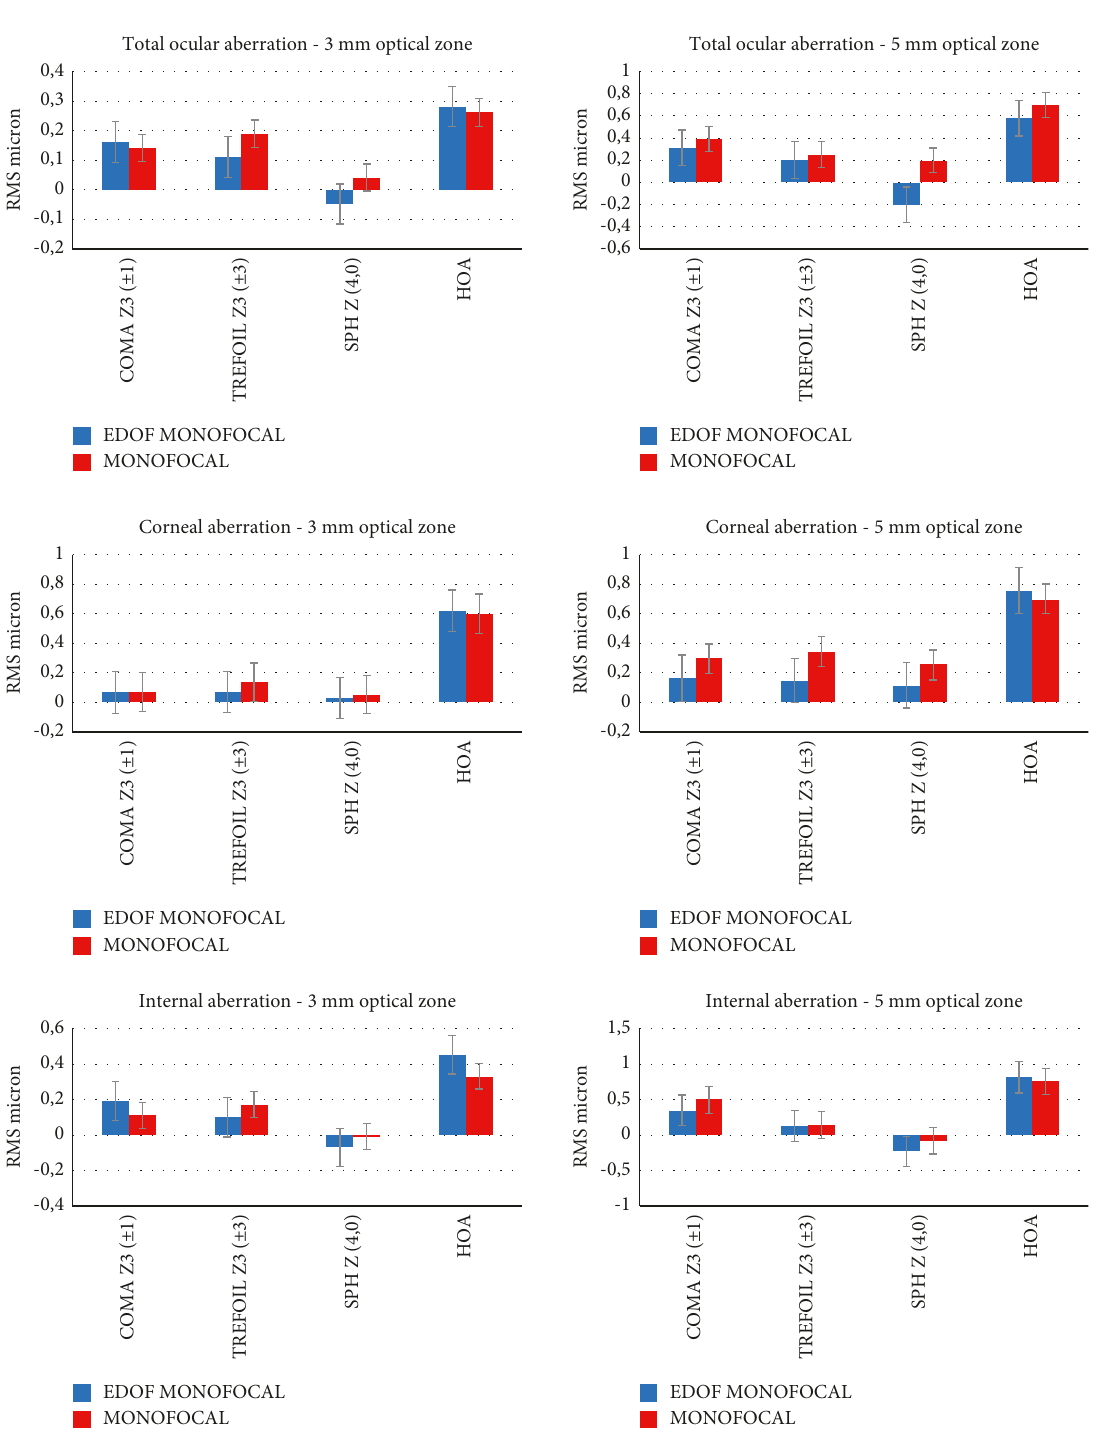
Figure 4: Higher-order aberrations at the 3.0mm and 5.0mm aperture diameter (EDOF: extended depth of focus; HOAs: total higher-order aberrations; RMS: root mean square; SPH: spherical